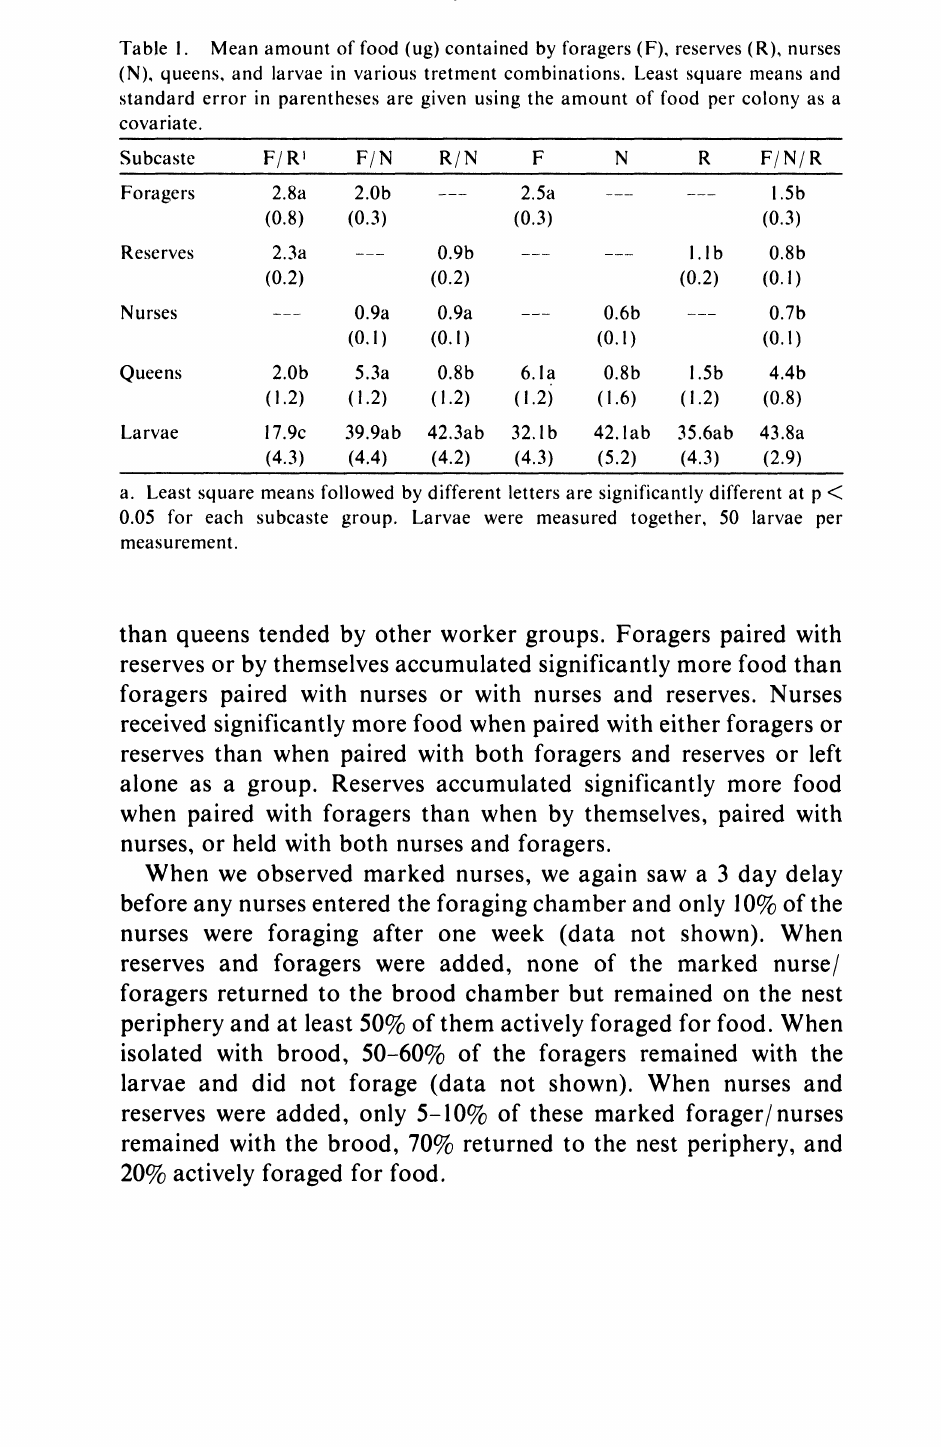
Table I. Mean amount of food (ug) contained by foragers (F), reserves (R), nurses (N), queens, and larvae in various tretment combinations. Least square means and standard error in parentheses are given using the amount of food per colony as a